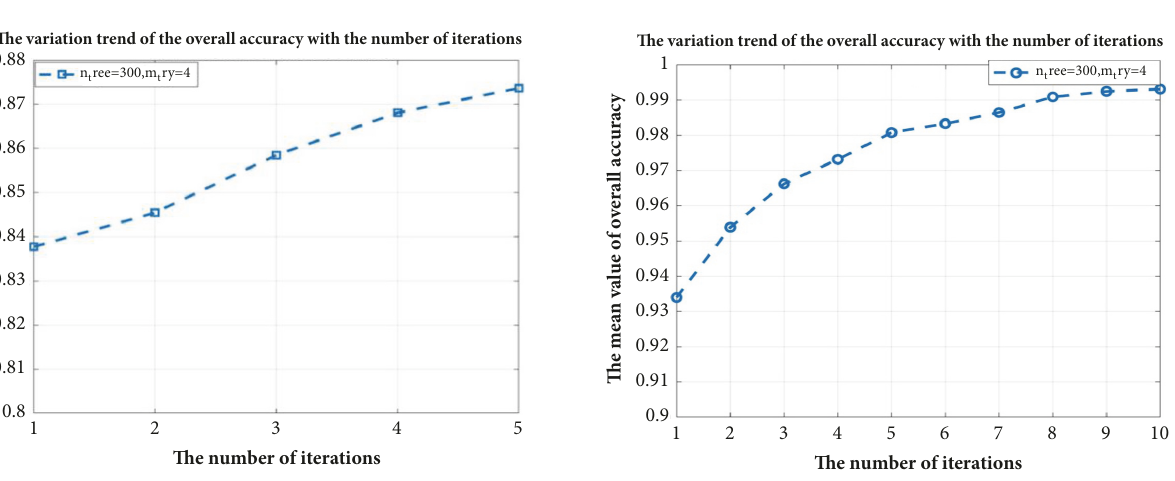
Figure 29: Classification accuracy trend of different initial and iterative condition of Hyperion data for method 1.